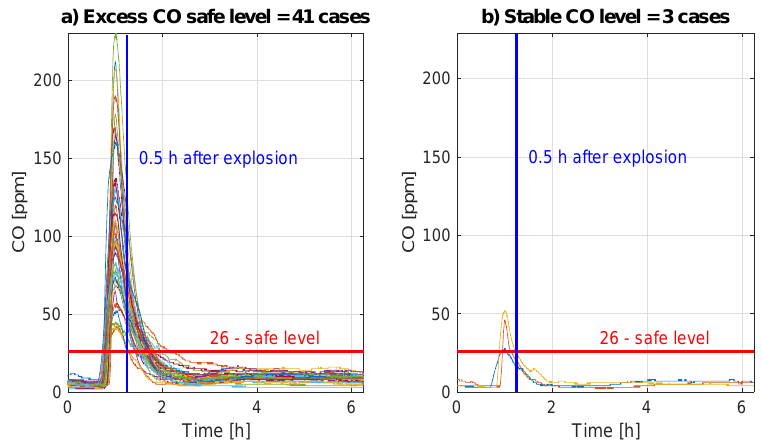
Figure 9. Panel ( a ) shows the processes of CO concentration related to the blasting events in case when the CO concentration does not reach the safe level before 30 min from the blasting moment, whereas panel ( b ) presents the same but in the case when the CO concentration reaches the safe level before 30 min from the blasting moment.